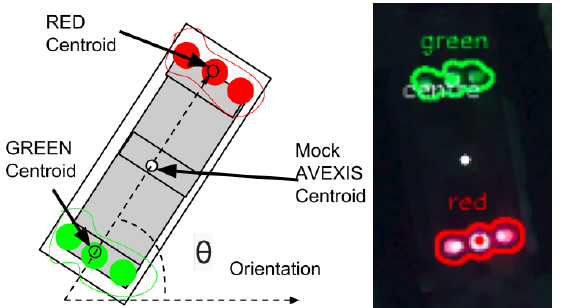
Figure 7. Image recognition of the pixel centroid of the AVEXIS TM . Identifying the red and green LEDs and marking a centroid for each colour. The white point in the middle shows the AVEXIS TM centroid after determining the mean of the red and green